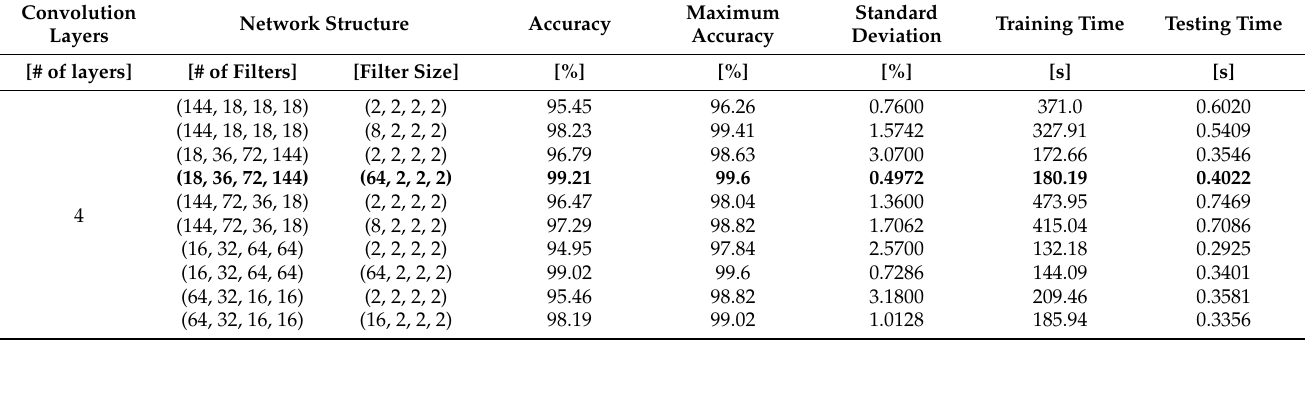
Table 5. Filter structure of the network.